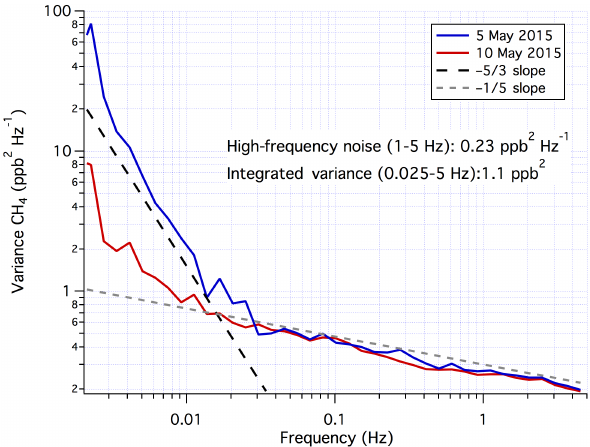
Figure 8. Variance spectra of CH 4 on two days of south-westerly winds. Variance at frequencies above ∼ 0.025Hz is dominated by noise, while ambient variability accounts for most of the low- frequency